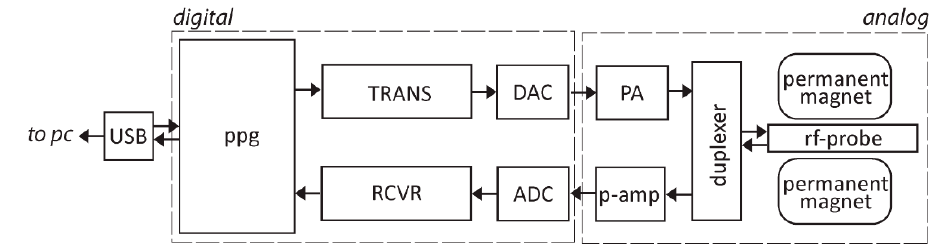
Figure 2. A simplified block diagram of the architecture of a software based radio (SDR)-based NMR spectrometer showing the separation of digital and analogue sections. The glossary is as follows: pulse programmer (PPG), receiver (RCVR), transmitter (TRANS), analog-digital converter (ADC), digital-analog converter (DAC), power amplifier (PA), preamplifier (p-amp), radio frequency (rf), and universal serial bus (USB).